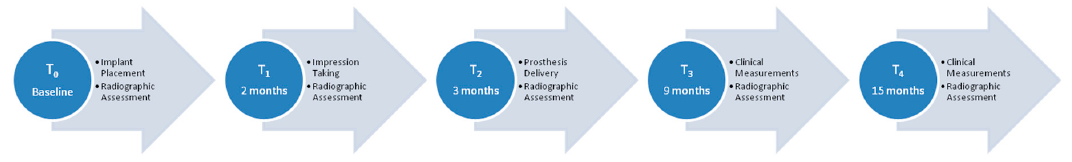
Figure 1. Summary of the visits.